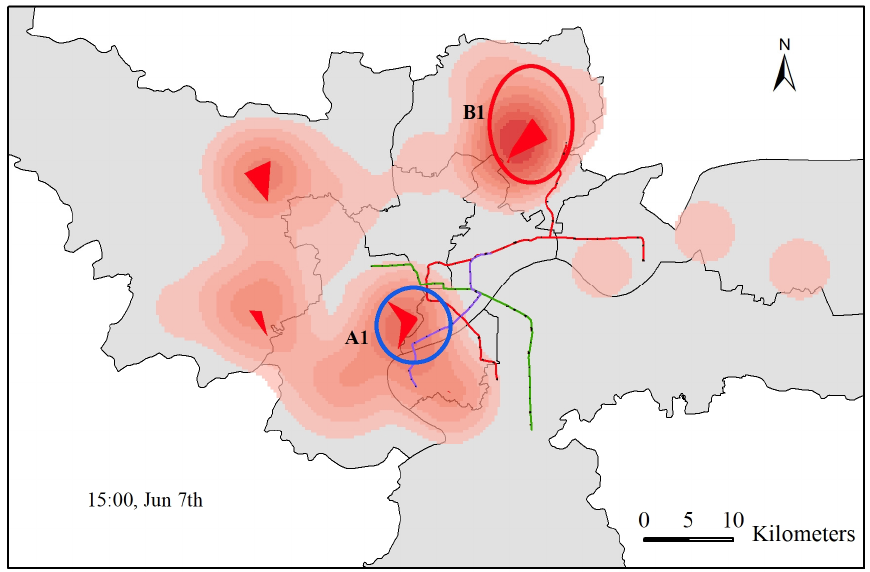
Figure 7. Distribution of imbalance usage areas (AOIs) on holiday afternoon.